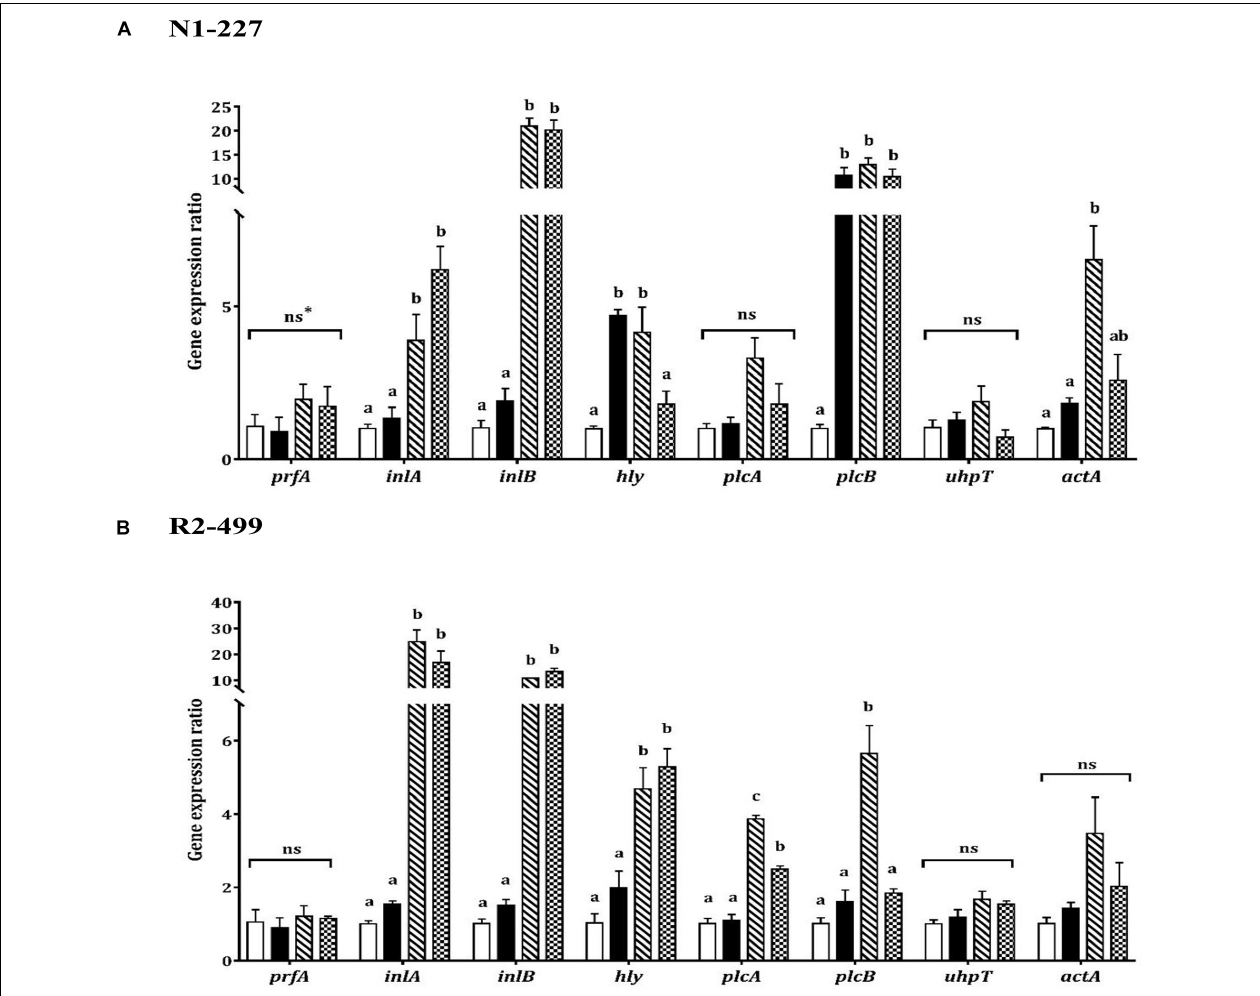
FIGURE 3 | Relative gene expression of virulence related genes in 20 min habituated Listeria monocytogenes (A) N1-227 and (B) R2-499 cells in comparison with non-habituated cells (baseline control, TSB pH 7.4, ). Habituated treatments include as follows: TSB at pH 6.0 (pH control, ), TSB at pH 6.0 with 4.75 mM of acetic acid ( ) and TSB pH 6.0 with 4.75 mM of L-lactic acid ( ). Error bars represent standard error of mean for two biological trails with three replicates for each trail. Different letters indicate that treatments are significantly different ( p < 0.05) as determined by one-way ANOVA with Tukey’s post-hoc tests. * ns,